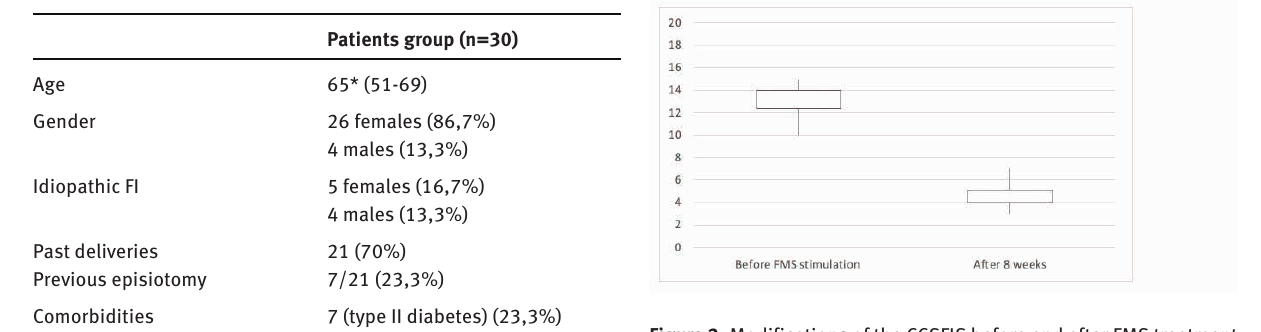
Figure 2: Modifications of the CCSFIS before and after FMS Table 2: Pre and post treatment clinical and instrumental parameters. Values are expressed as mean or number of cases (*). FMS (functional extracorporeal magnetic stimulation); CCSFIS (Cleveland Clinic Faecal Incontinence Score); FiQL (Fecal Incontinence Quality of Life Scale);